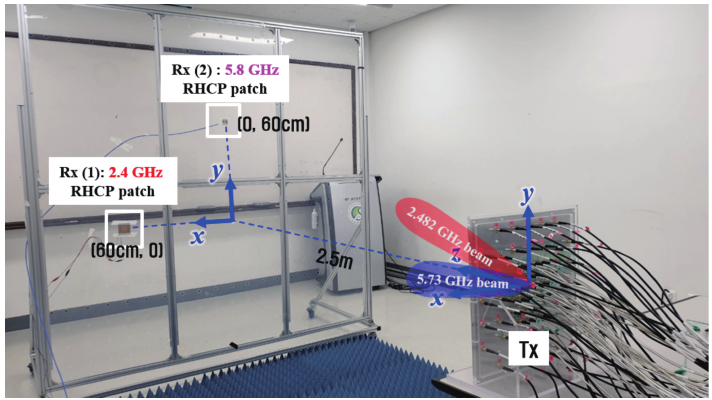
Figure 20. Dual-band RF WPT experiment set-up for transmitting 2.482 and 5.73 GHz RF power separately to two received